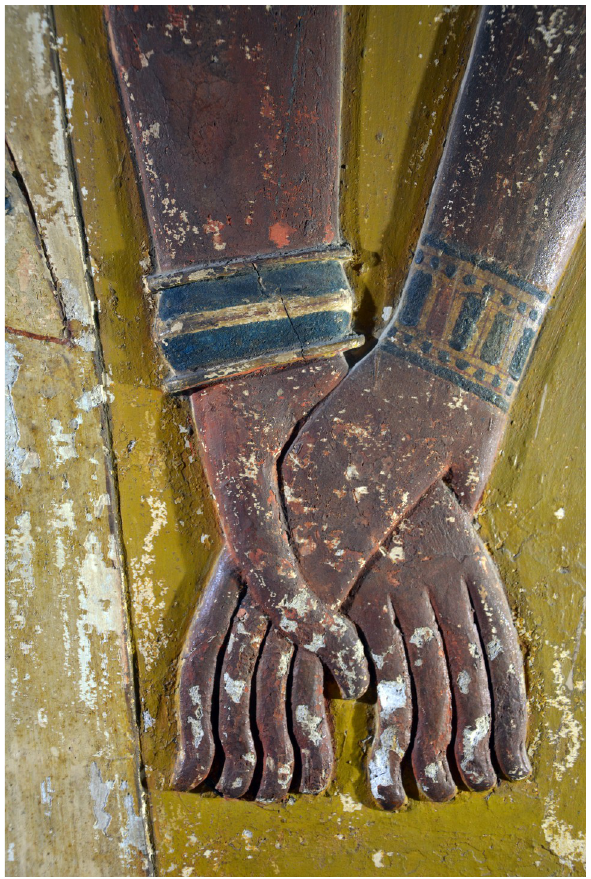
Figure 8. HD photographic mapping of the surface. To the main portions of carved limestone and tendentially homogeneous layers of color, are added the negative units of cracks and failures. Among the latter, the most widespread are the gaps of color, divided into two categories: loss of the painting layer or loss of the deeper and thicker preparatory layer. In another group have been included the gaps which have been covered by a subsequent layer of color. Finally the layers in detaching have been mapped, together with surface deposits (dirt) and mixture integrations (Figure 9).